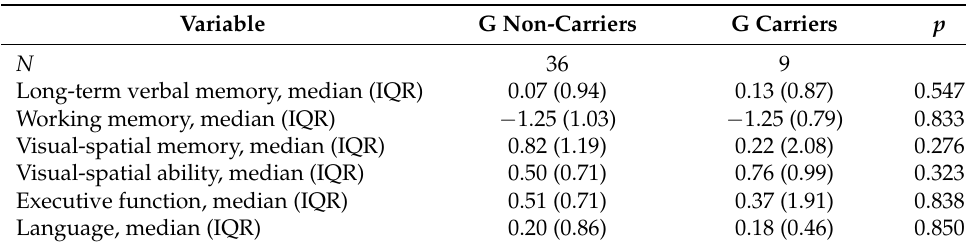
Table 3. Comparison of the demographic, cognitive, and genetic features between G carriers and G non-carriers at the last follow-up evaluation.